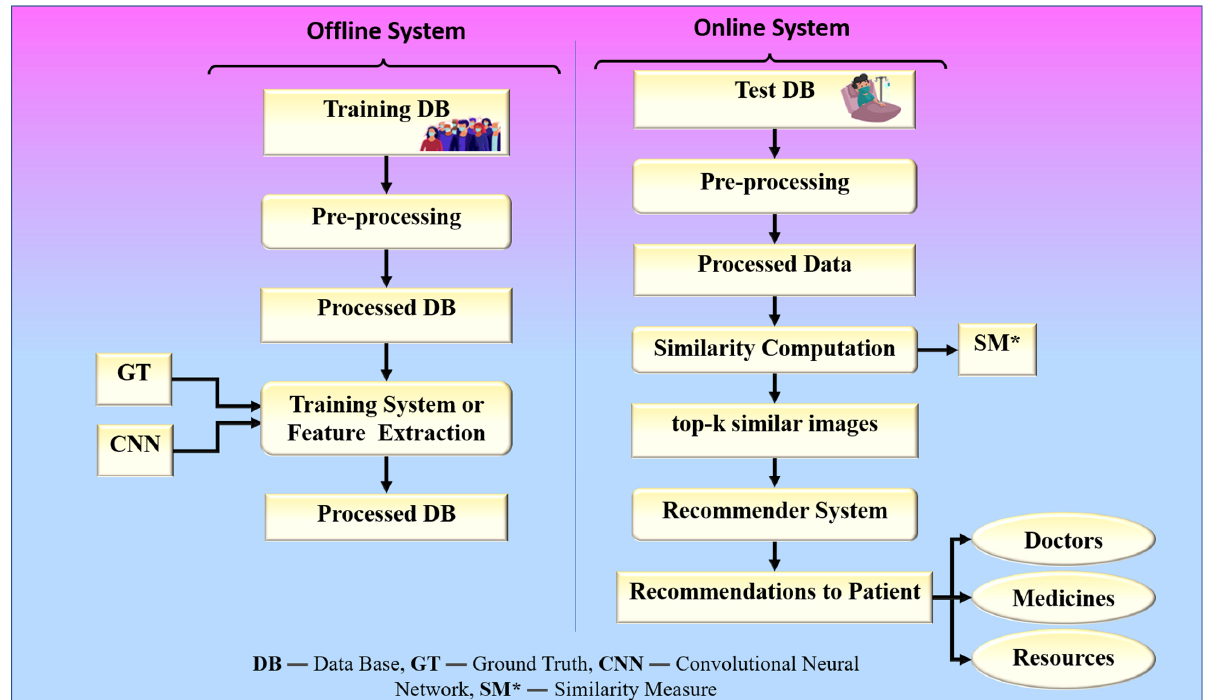
Figure 8. The architecture or local system for the proposed system.